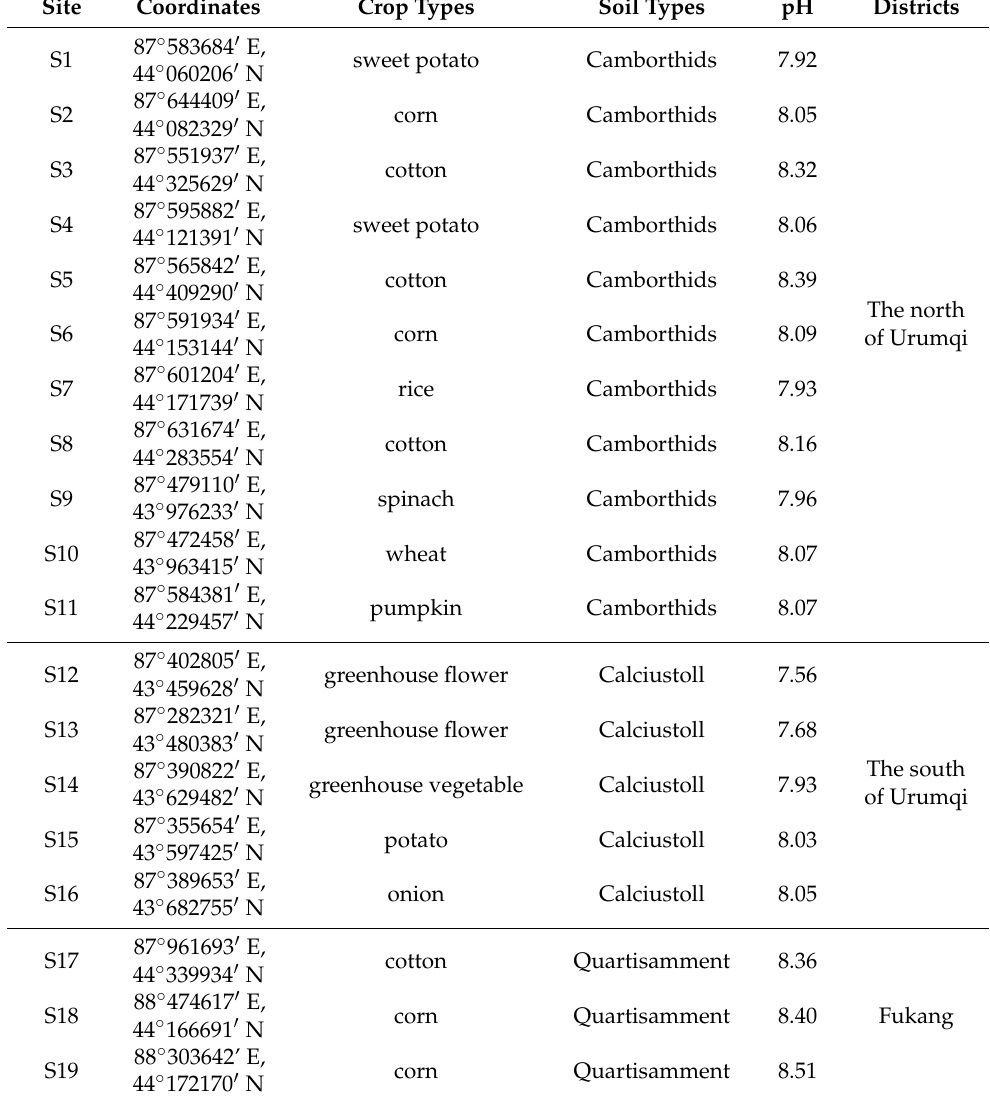
Table 1. Characteristics of the sampling